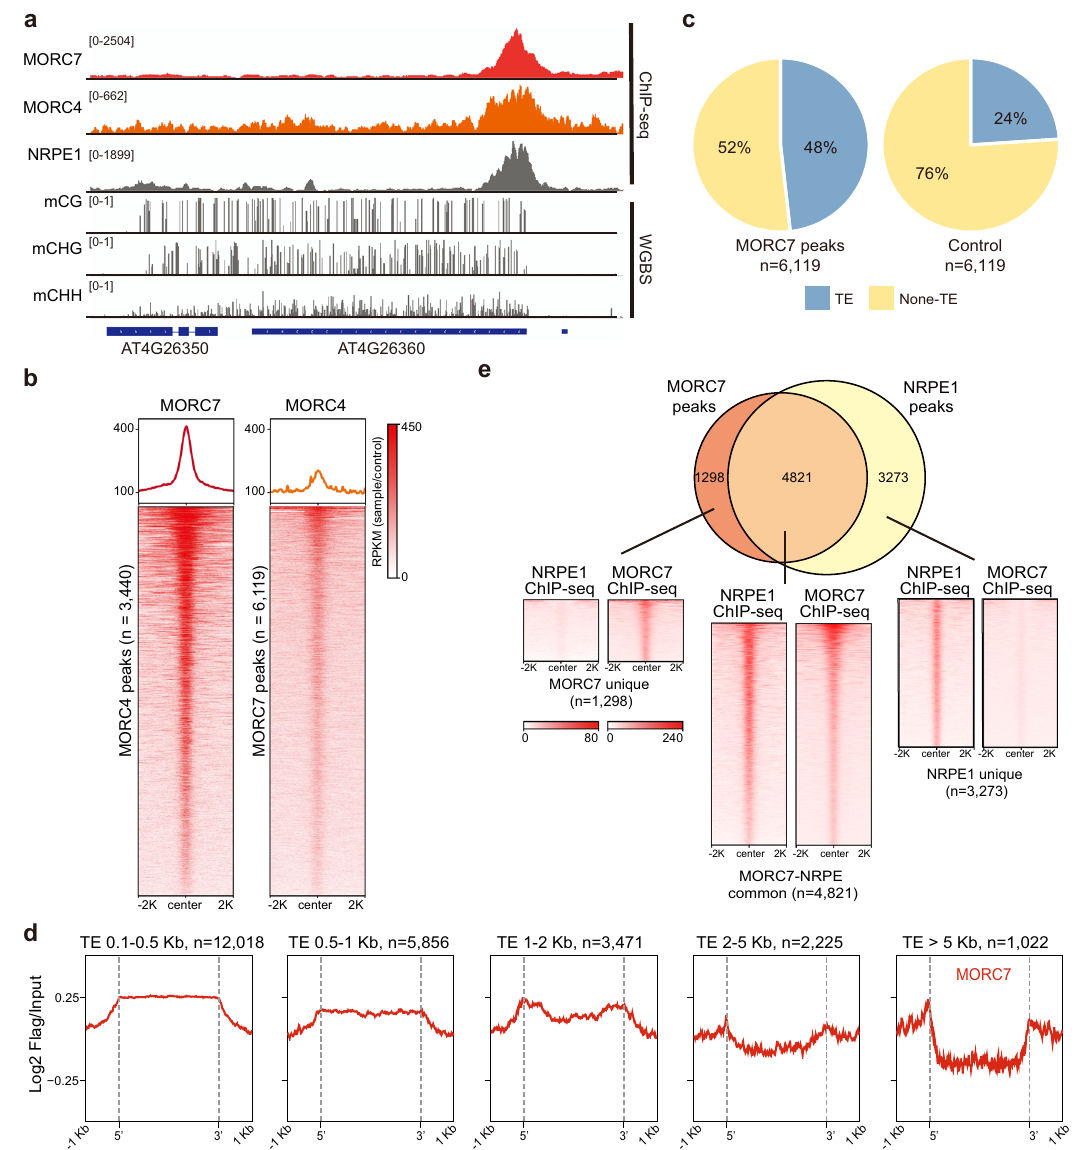
Fig. 1 MORC4 and MORC7 largely co-localize at a subset of RdDM loci. a Screenshot of MORC4, MORC7, NRPE1 ChIP-seq (normalized by RPKM) and methylation level at a representative locus. b Metaplot and heatmap showing enrichment of MORC4 and MORC7 ChIP-seq signal over MORC7 ( n = 6119) and MORC4 ( n = 3440) peak regions, respectively. c Pie chart showing the percentage of MORC7 peaks overlapping with TEs. d Metaplot showing MORC7 ChIP-seq signal (log 2 FLAG/input) over TEs categorized by different lengths. e Venn diagram (top) showing the relationship between MORC7 and NRPE1 peaks, and heatmap (bottom) showing the enrichment of MORC7 and NPRE1 over MORC7 unique (left, n = 1298), MORC7-NRPE1 common (middle, n = 4821) and NRPE1 unique (right, n = 3273)